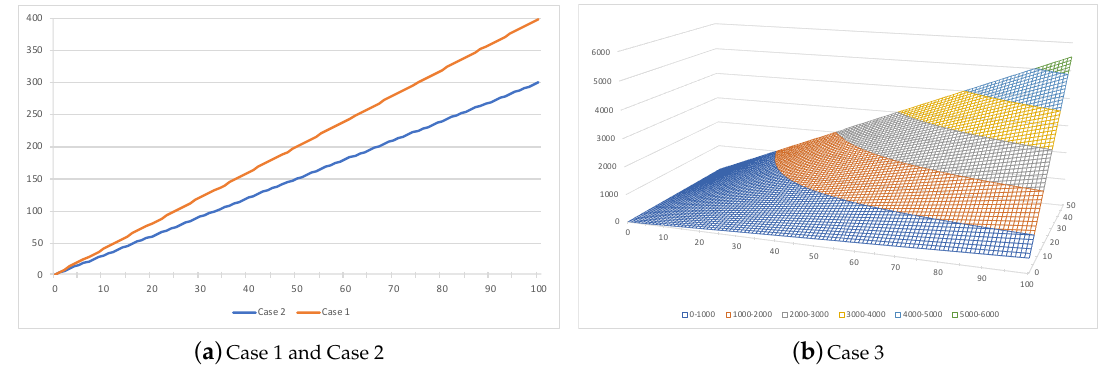
Figure 19. The evolution of the amount of “unhandled”